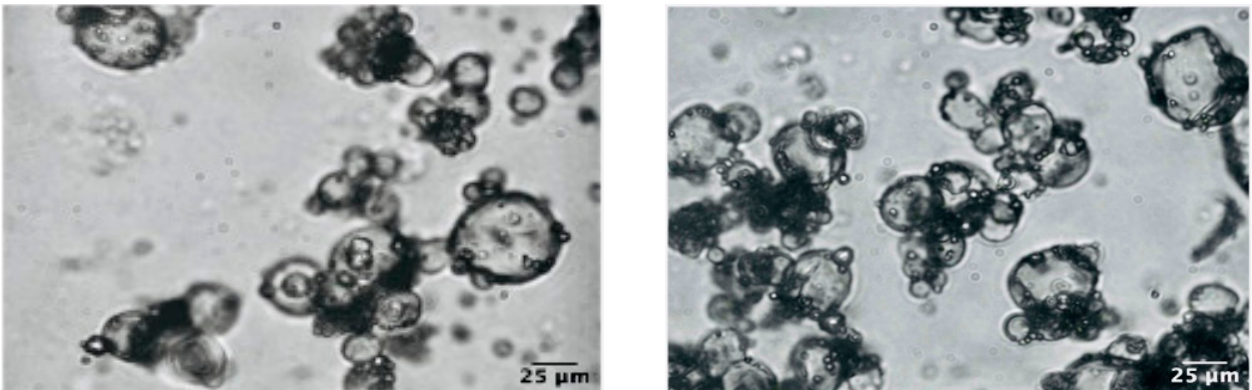
Figure 4. Microphotographs of the optimized microencapsulate QP at 100× magnification.